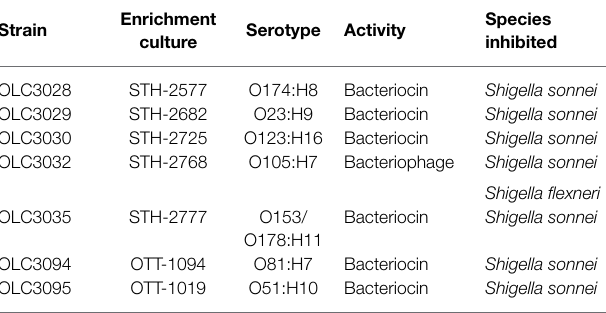
TABLE 2 | Inhibitor-producing organisms recovered from food enrichment